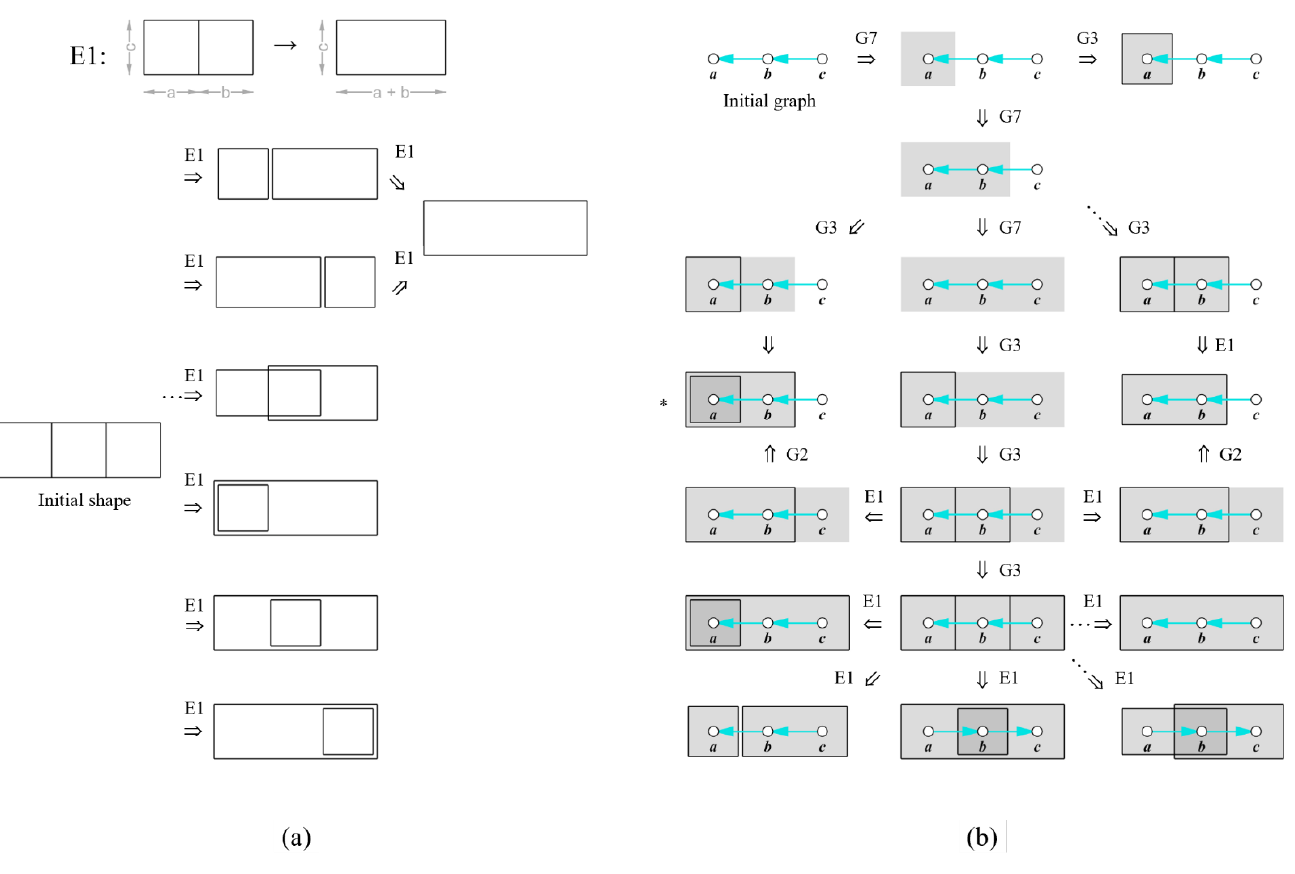
Figure 8. Reduction rules for adjacent rectangles and example iterations ( a ) with their application graph-to-shape rules ( b ).